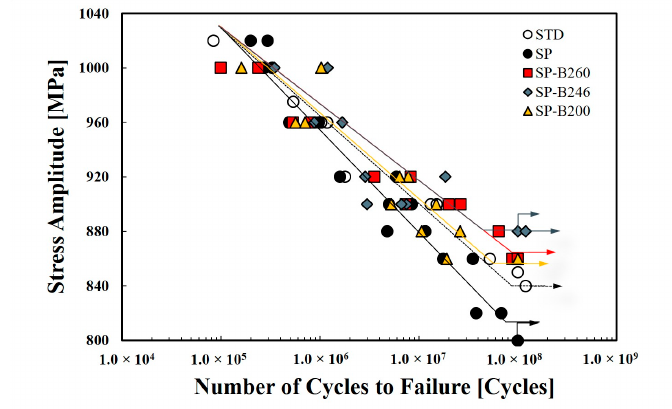
Figure 7. S–N curve obtained from the fatigue test (20 kHz, R = − 1).